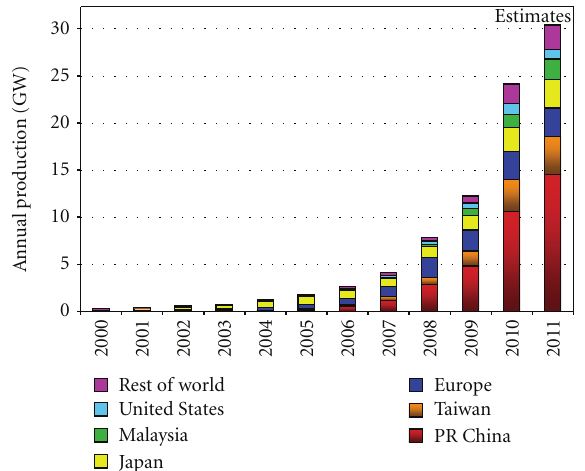
Figure 1: Worldwide PV production from 2000 to 2011. (data source: PV News [2], Photon International [3], and own analysis).